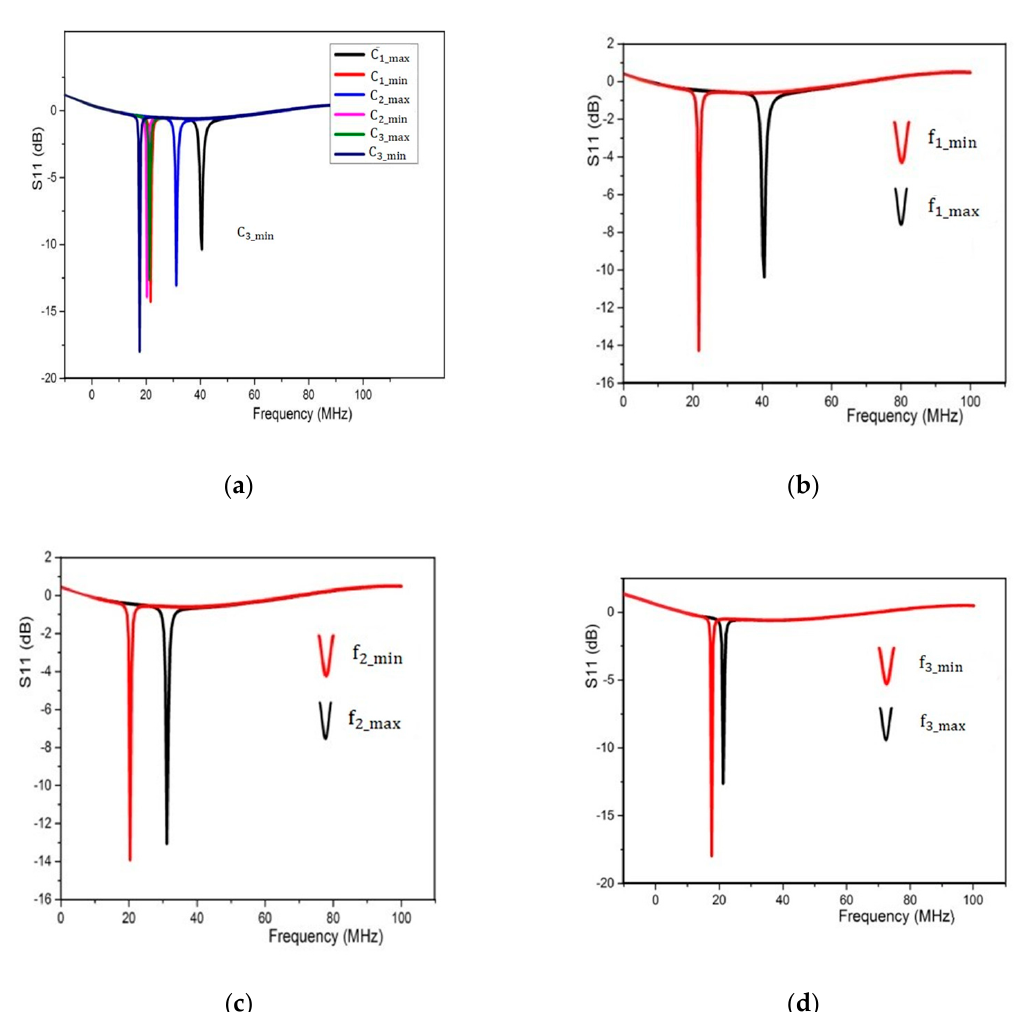
Figure 8. Experimental results of detected resonant frequency versus S11 parameter of proposed LC sensor system, ( a ) combined representation of detected frequencies for maximum and minimum values of three capacitors, ( b ) curves for variation in C 1 , ( c ) curves for variation in C 2 , ( d ) curves for variation in C 3